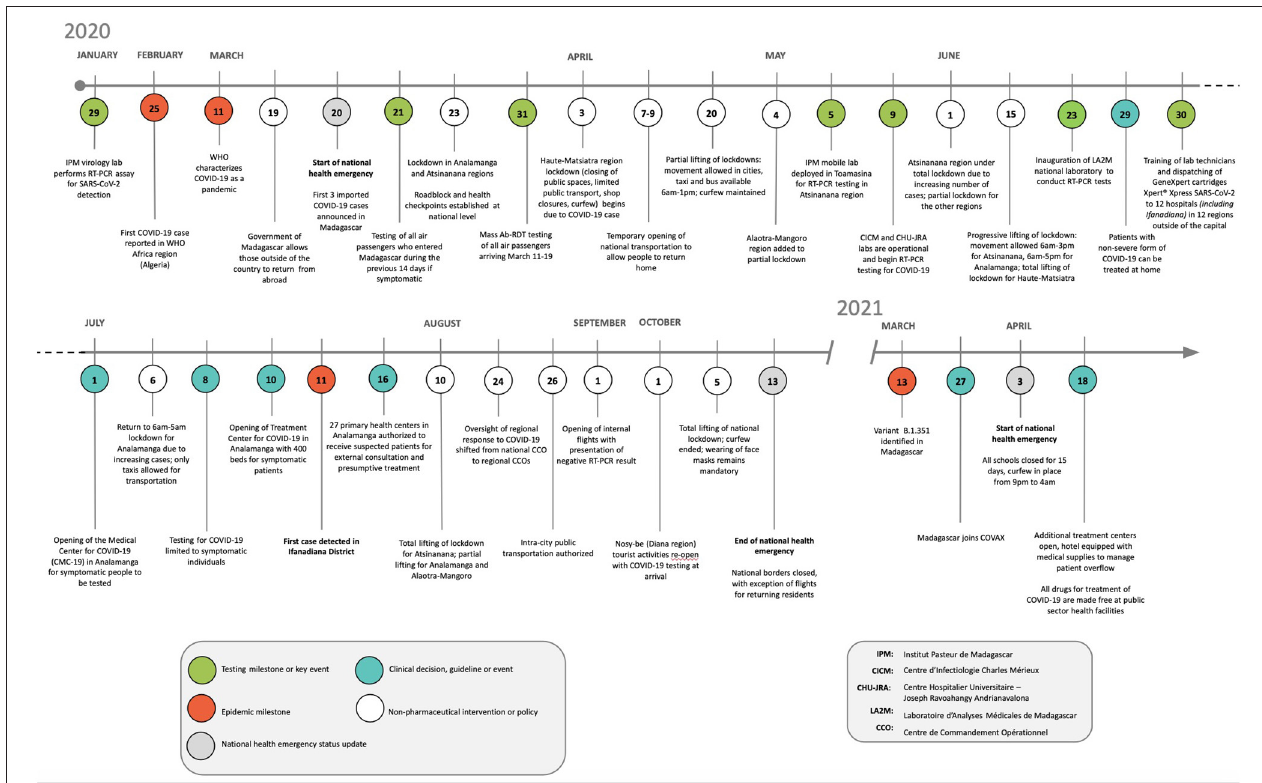
FIGURE 2 | Timeline of policies and interventions in response to COVID-19 in